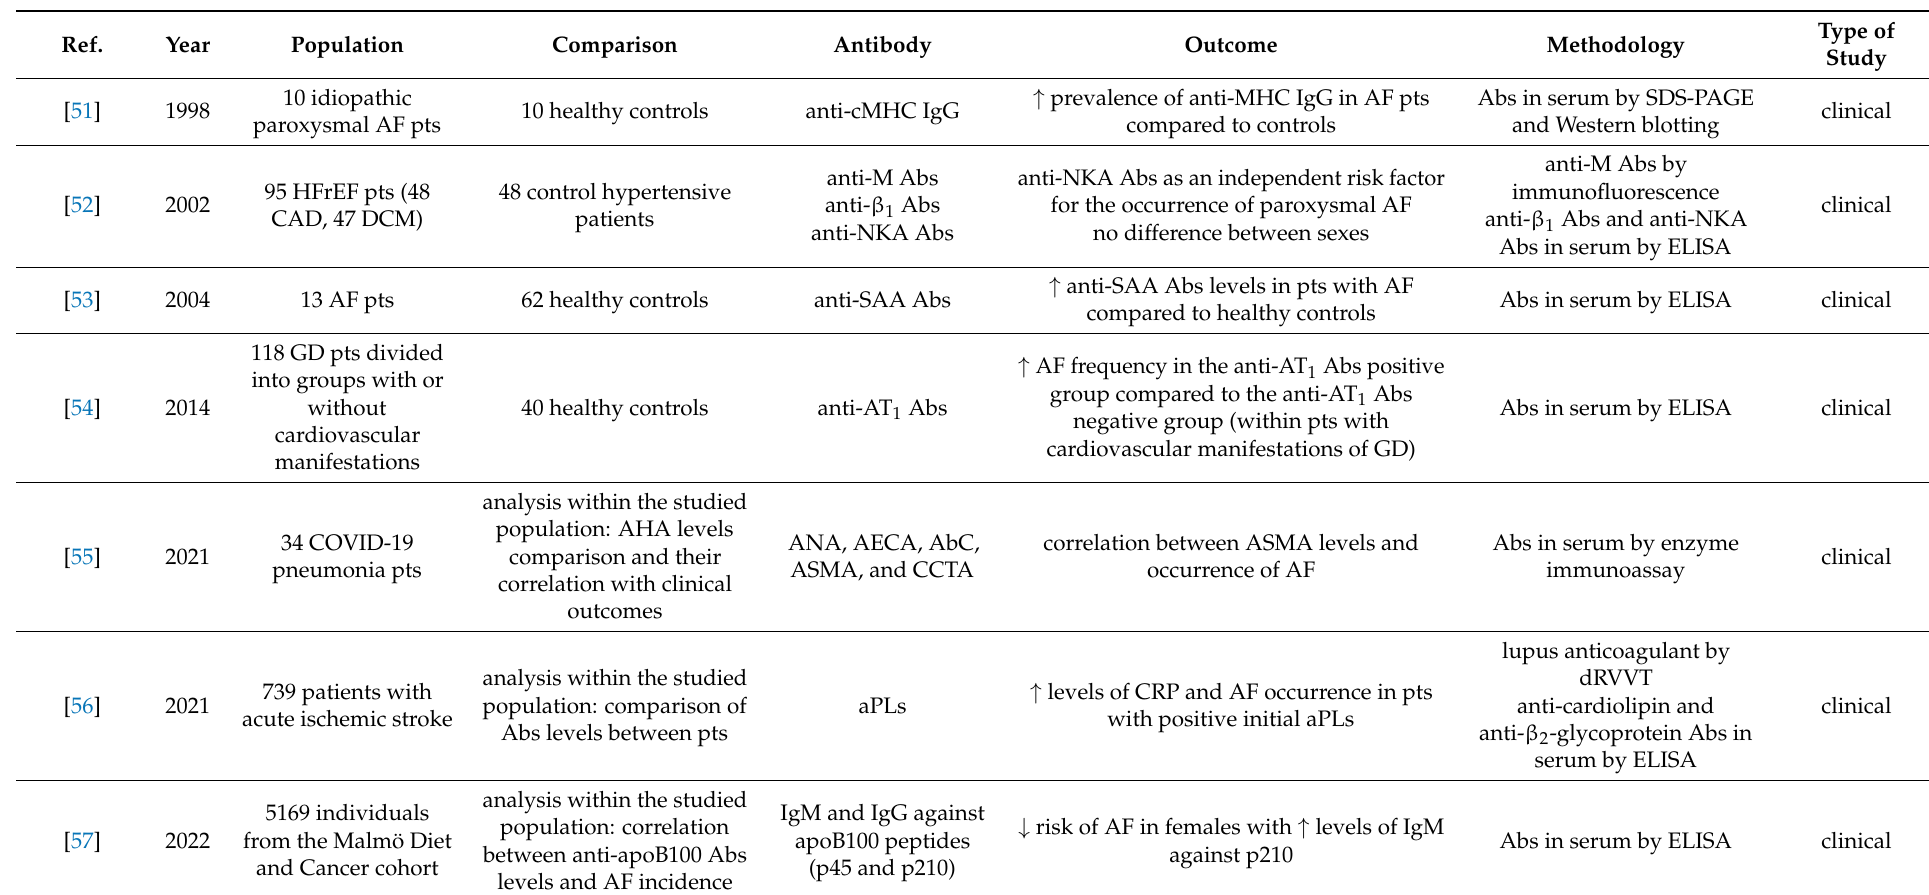
Table 5. Summary of recent research investigating other types of autoantibodies.